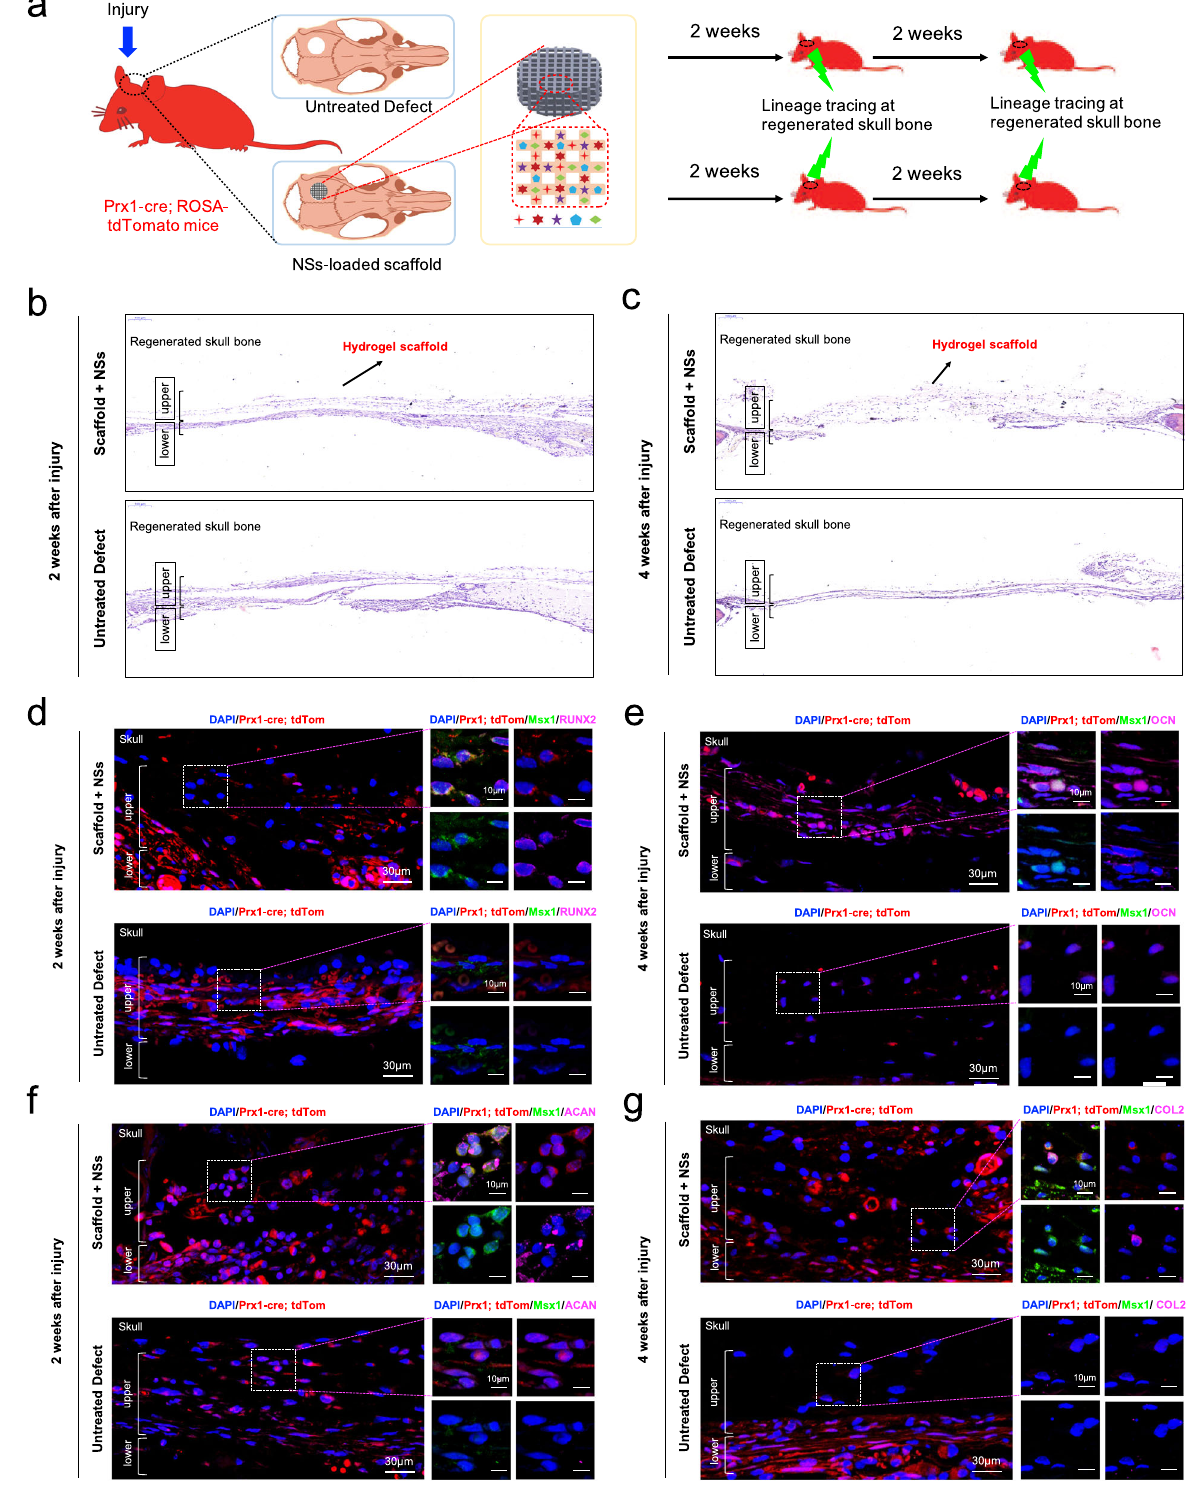
Fig.7|Msx1 + SSCssubsetisasourceofosteogenesisandcloselycorrelateswith endochondralossi fi cation.a SchematicoftheassessmentofMsx1 + SSCssubsetin differentiation hierarchy by Prx1-lineage tracing mice. b , c HE staining of newly formed calvarium tissues in skullbone injuryat2 weeks and 4 weeksafter surgery,